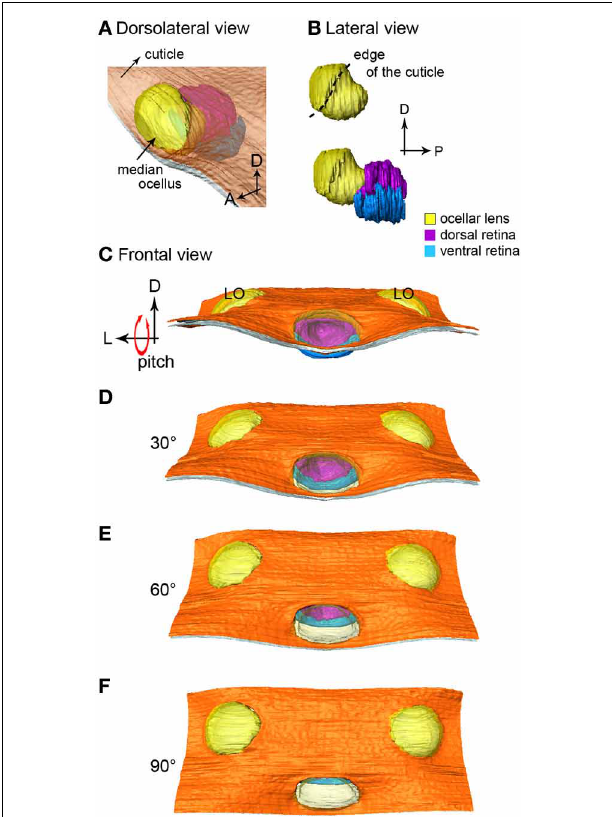
FIGURE 2 | The 3-D reconstruction of the honeybee median ocellus. (A) Dorso-lateral view of the median ocellus with the cuticle in view. (B) Lateral views of the median ocellar lens (l, shown in yellow) and dorsal and ventral retinas. The lens of the median ocellus is elongated downward, the retinas are positioned downwards and posteriorly in relation to the lens. (C–F) Simulation of a pitching movement of the model. (C) A frontal view of the median ocellus: only the dorsal retina can be seen through the median ocellar lens (the ventral retina is under the cuticle). (F) A dorsal view of the ocelli: only the ventral retina can be seen. Abbreviations: D, dorsal; L, lateral; LO, lateral ocellus; P,